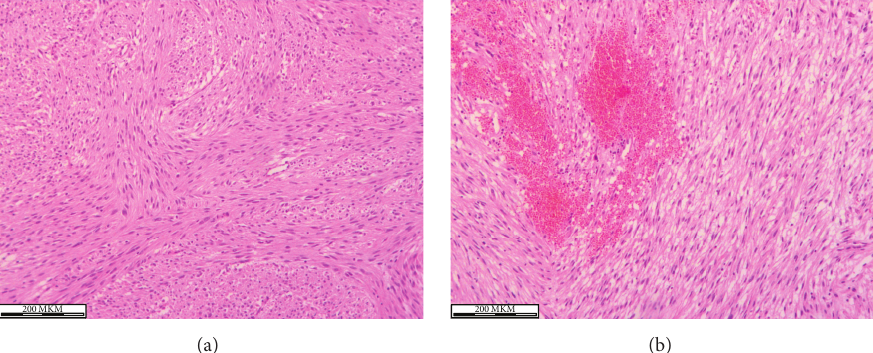
Figure3: Histopathology of angioleiomyoma showing (a)intersecting bundles of spindlecells and (b)capillary channels with blood